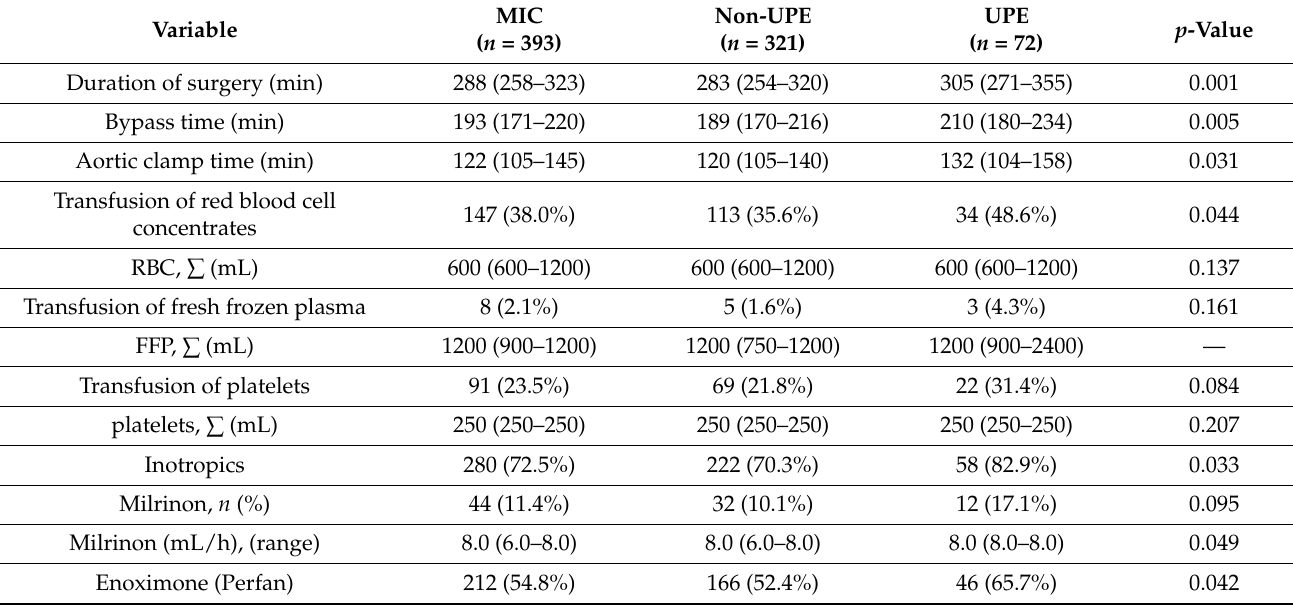
Table 2. Intraoperative details of MIMVS